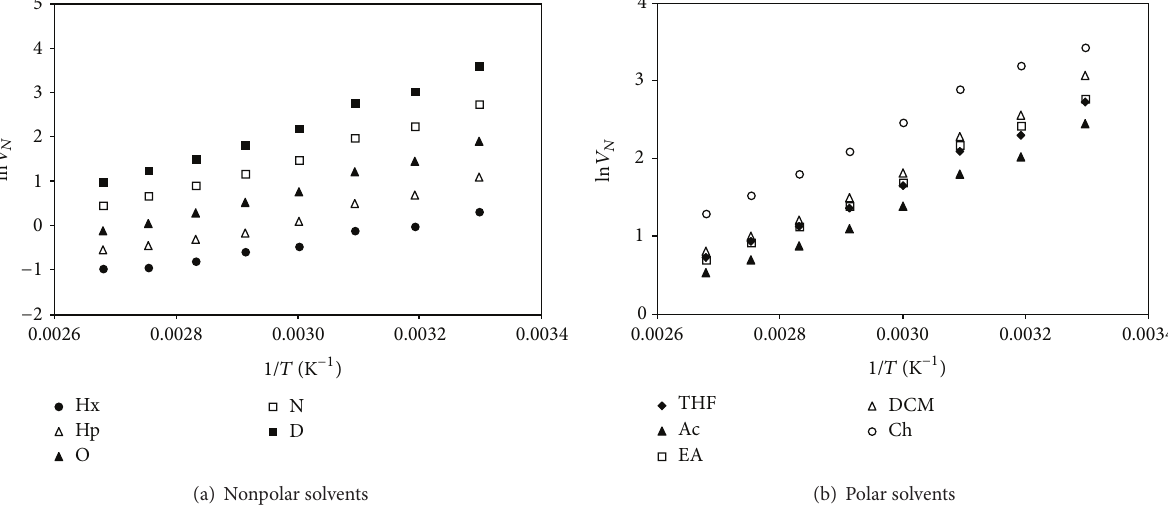
Figure 3: The retention diagrams, 𝑉 𝑁 , of (a) nonpolar solvents and (b) polar solvents adsorbed onto PEG.